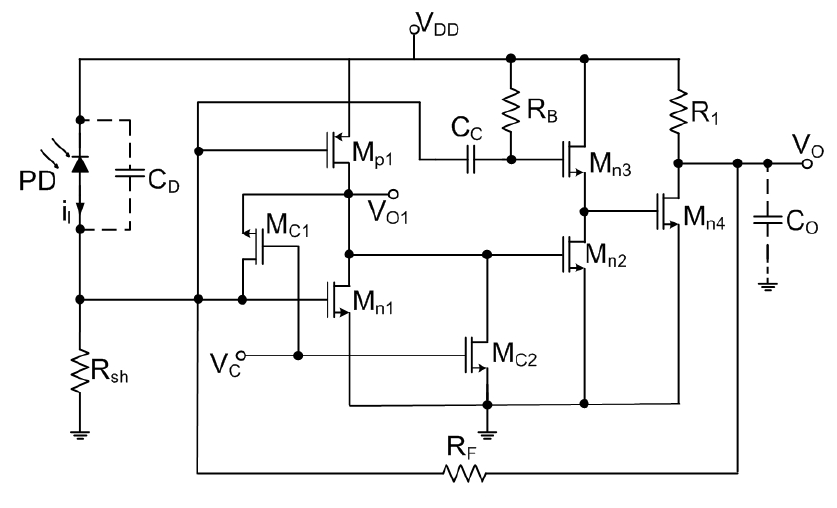
Figure 10. Three-stage inverter TIA with noise cancelation